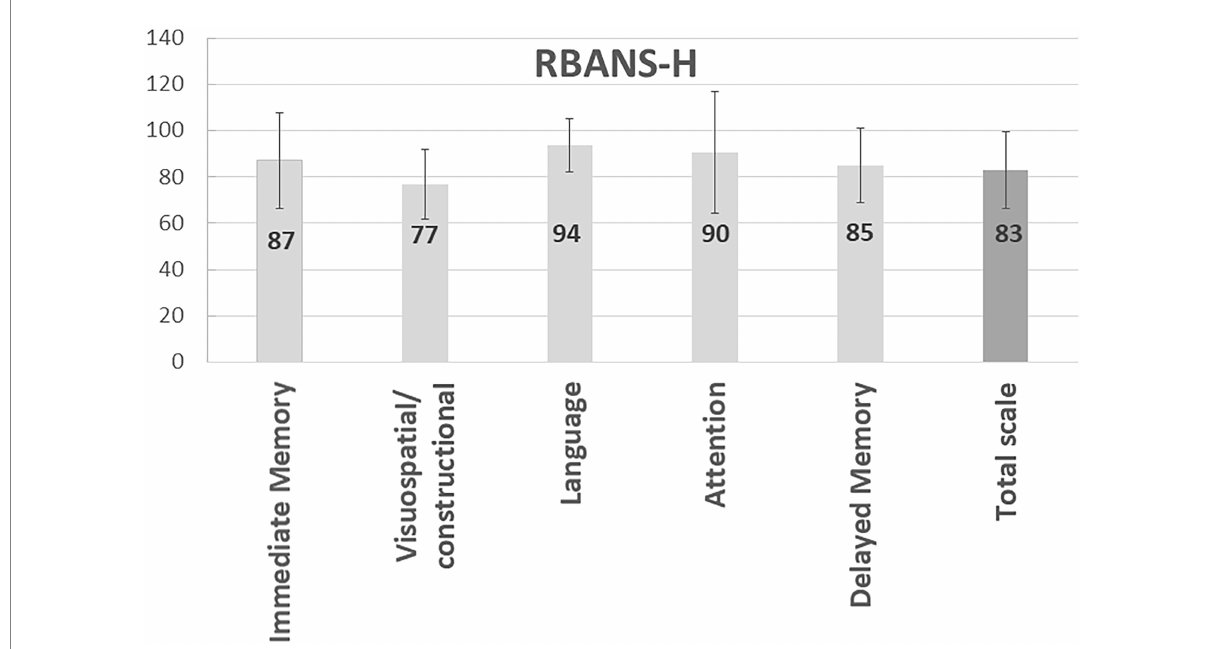
FIGURE 3 Measurement of cognition in study participants. The bars represent the mean and standard deviation of the RBANS-H total and domains scores.